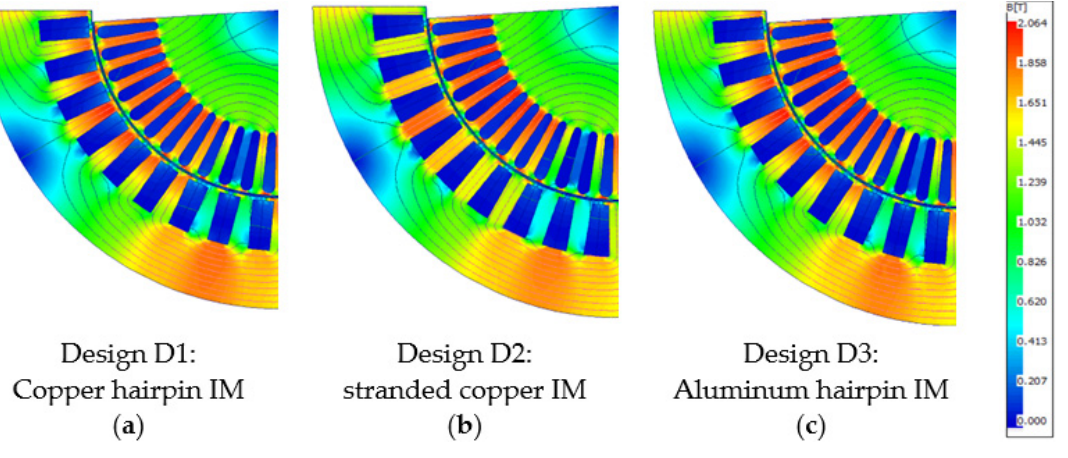
Figure 3. Flux density and flux isoline distribution: ( a ) design D1; ( b ) design D2; ( c ) design D3.